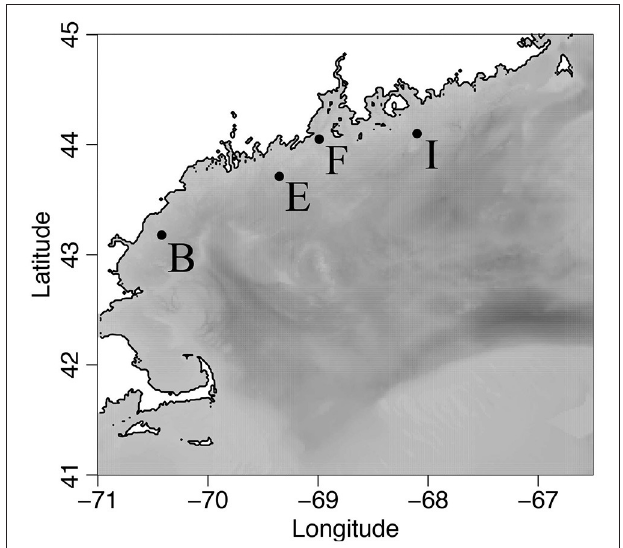
FIGURE 1 | Site map of NERACOOS buoys from which water temperatures at 50m depth were derived. Buoys B, E, and I are representative of the Western, Central, and Eastern Maine Shelf, respectively. Buoy F, at the mouth of Penobscot Bay, is influenced by river